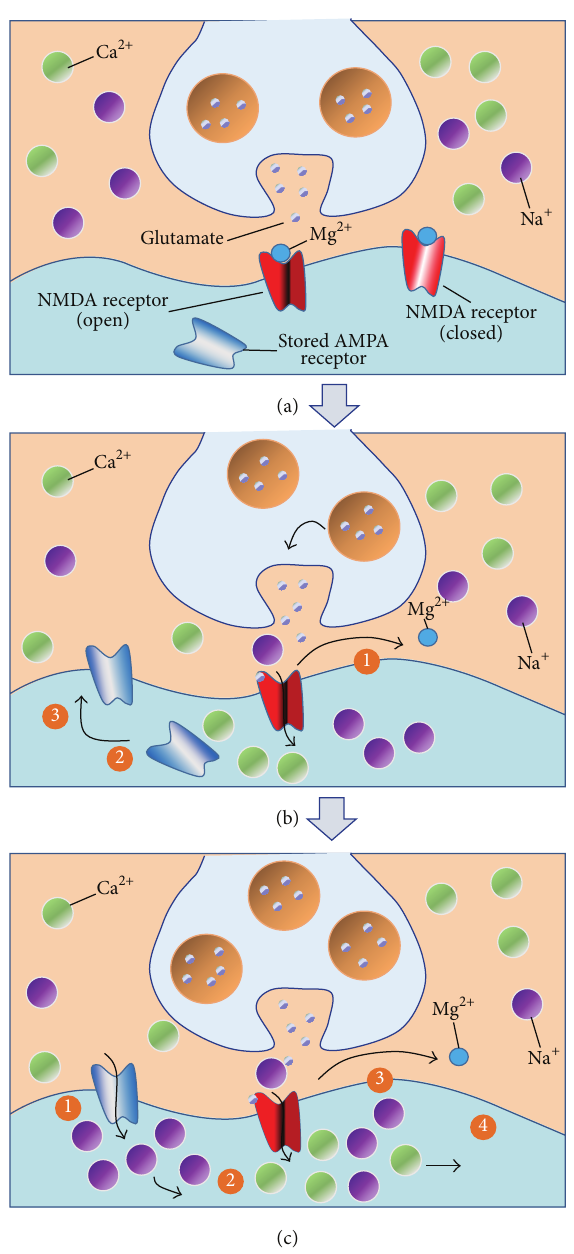
Figure 1: (a) Synapse prior to long term potentiation: NMDA and AMPA are two types of receptors at the postsynaptic neuron, for the neurotransmitter glutamate. NMDA receptors open in response to glutamate prior to potentiation. However, they are blocked by Mg 2+ . (b) Establishing LTP: NMDA receptors release Mg 2+ after depolarization of the postsynaptic membrane in response to the activity. Na +